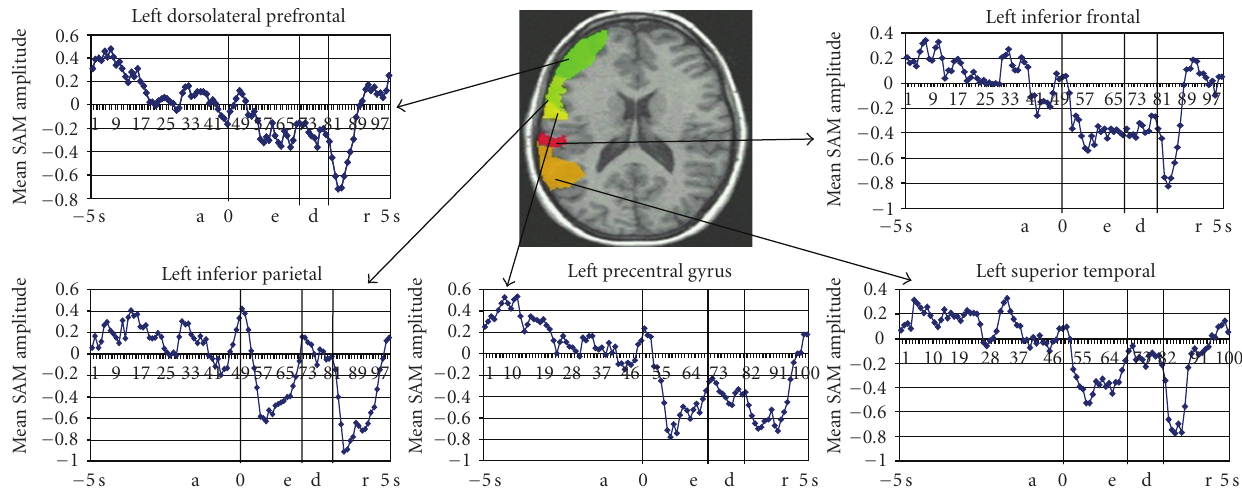
Figure 2: ROI templates drawn on a representative participant’s MRI scan along with the average time courses from each of the left hemisphere ROIs. a: anticipatory period; e: encoding period; d: delay; r: response